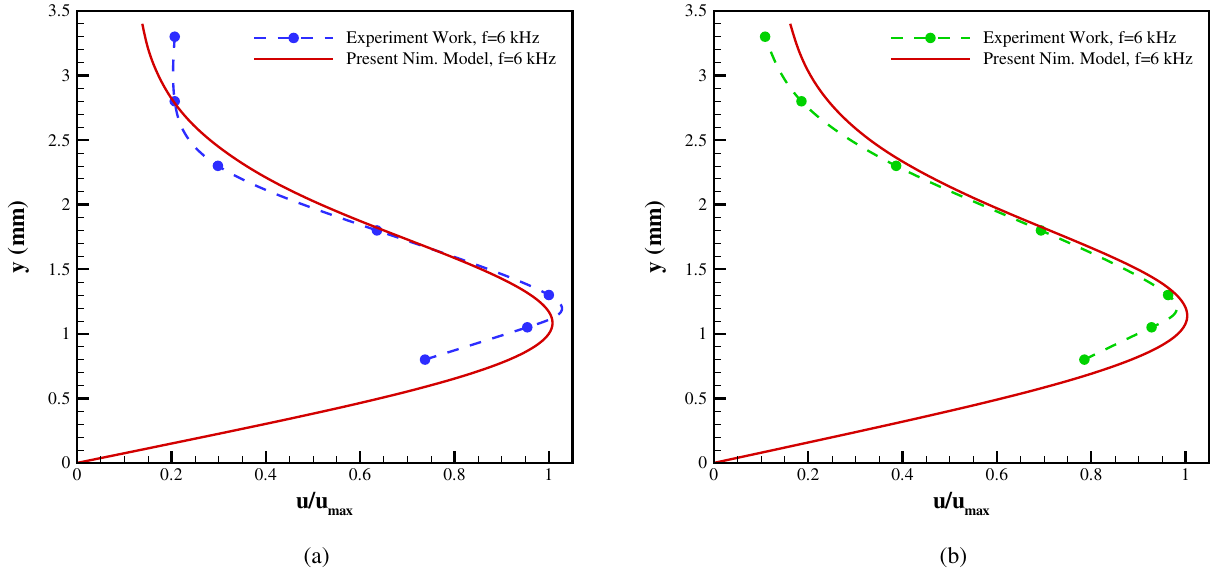
Figure 7. Comparison of velocity profiles from the experiments and the presented numerical scheme for ( a ) V = 6 kVpp, f = 6 kHz, and ( b ) V = 6 kVpp, f = 8 kHz, at 12.5 mm downstream of the exposed electrode’s leading edge.